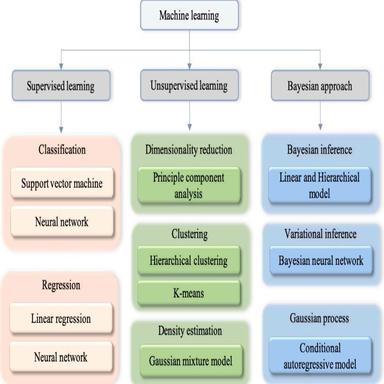
Taxonomy of ML methods and representative algorithms.